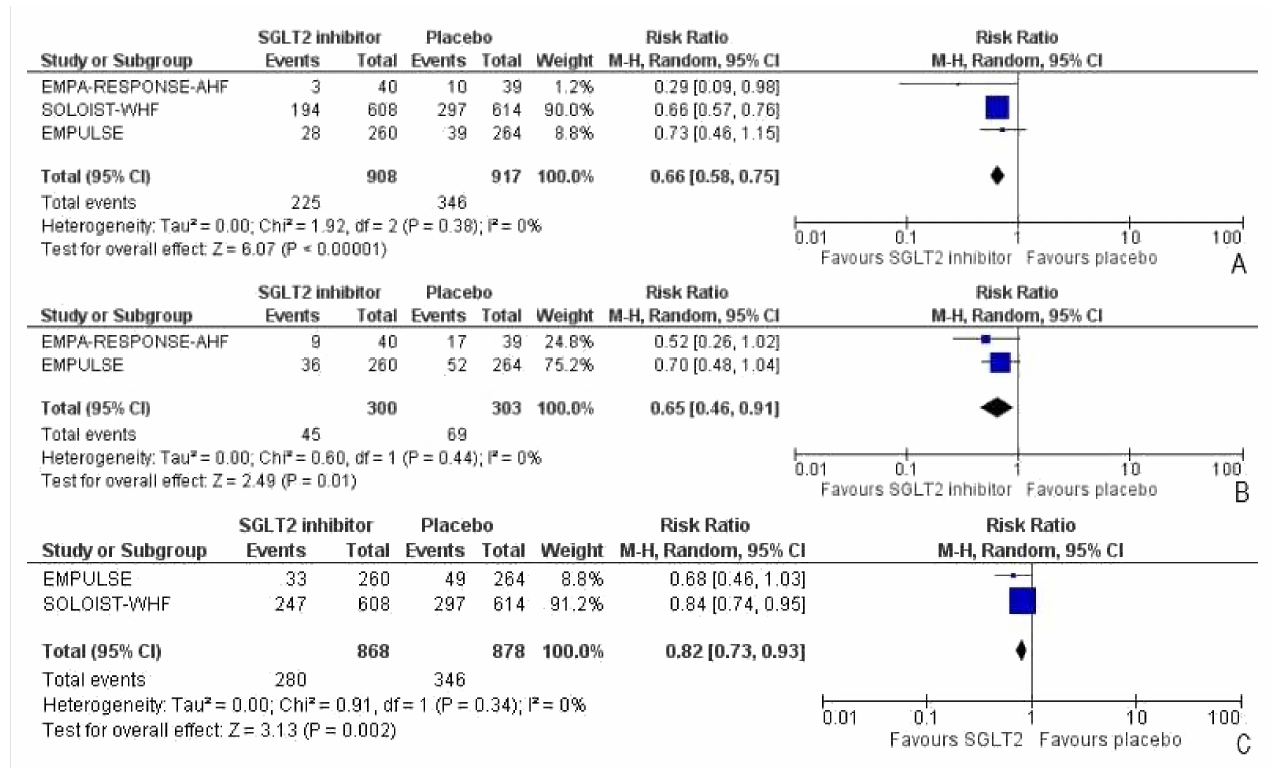
Figure 4. Forest plot for ( A ) the number of participants with heart failure events (the total number of participants presented who had one or more HFEs in the duration of the study), ( B ) the number of heart failure events, and ( C ) the number of patients with either HFEs or death attributable to cardiovascular causes [25–27].